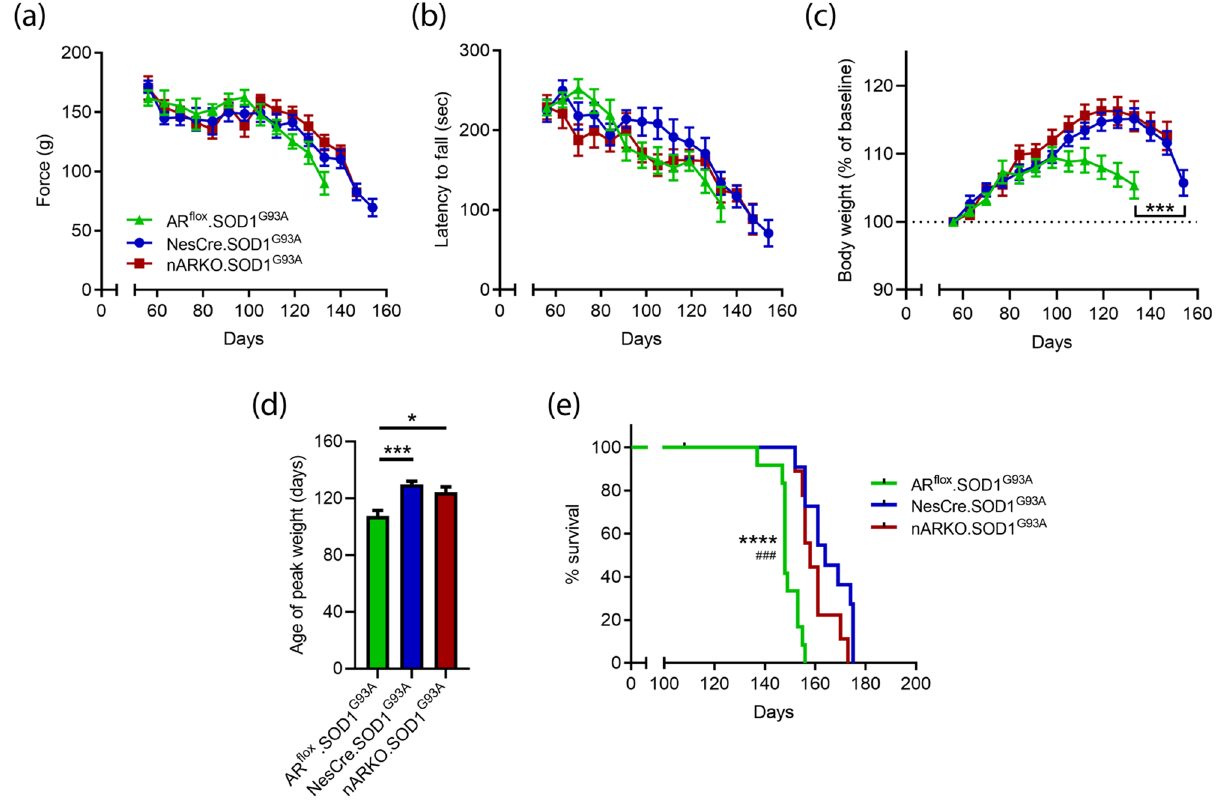
Figure 3. Neural deletion of AR does not alter disease course in SOD1 G93A male mice. Motor function assessment by (a) four limb grip strength and (b) rotarod performance. (c) Body weight analysis of AR flox x NesCre x SOD1 G93A cross mice over disease course; ***P < 0.001 vs. NesCre:SOD1 G93A by two-way ANOVA with Tukey’s multiple comparison test comparing main genotype effect. (d) Age in weeks when peak weight occurred; P < 0.001 by one-way ANOVA with Dunnett’s multiple comparison test comparing all genotypes to NesCre:SOD1 G93A . (e) Kaplan–Meier curves show reduced survival in AR flox :SOD1 G93A compared to NesCre:SOD1 G93A (****P < 0.0001) and nARKO:SOD1 G93A ( ### P < 0.001). All values presented as mean ± SEM; n = 9–12 mice per